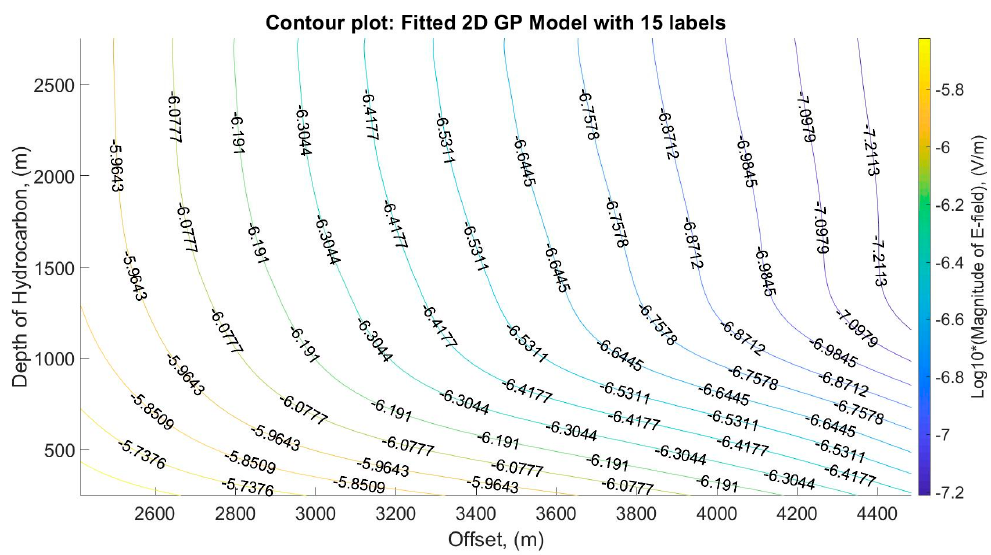
Figure 8. Contour plot of EM profiles (amplitude) for various offset distances (~2400 to ~4500 m) and hydrocarbon depths (250–2750 m) at a frequency of 0.25 Hz with 15 labels.